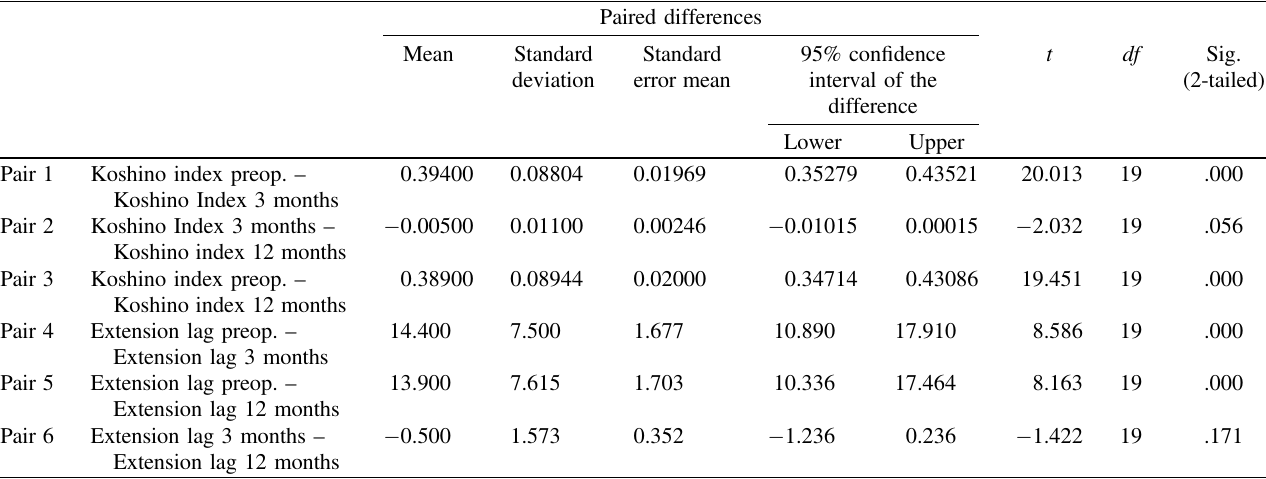
Table 3. Paired T -test reveals no signi fi cant change between the 3rd and 12th months regarding Koshino index and extensor